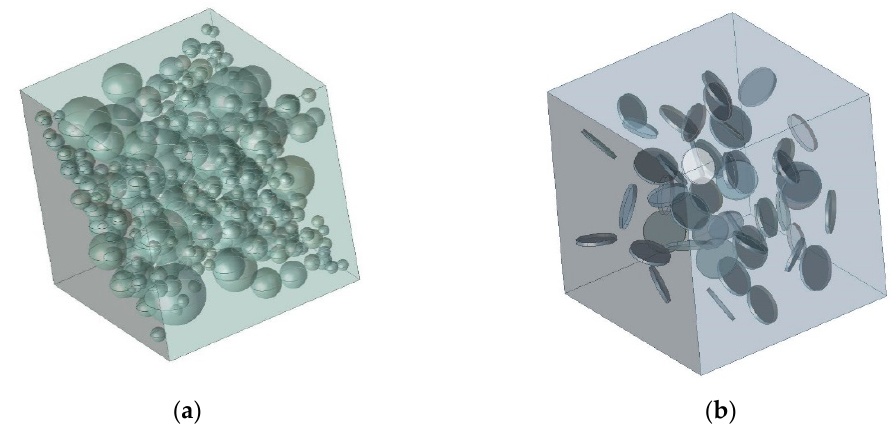
Figure 5. The true stress–strain curve for flaky kaolin. A cube with an edge length of a = 200 μ m for a spherical filler and a = 50 μ m for a short cylindrical filler, with the properties of a matrix saturated with spherical or cylin- drical inclusions with the properties of the filler is accepted as a solid-state model (Figure 6). The number of filler bodies was taken for reasons of achieving its volume content in the composite of 24.12% for spherical and 1.87% for short cylindrical.